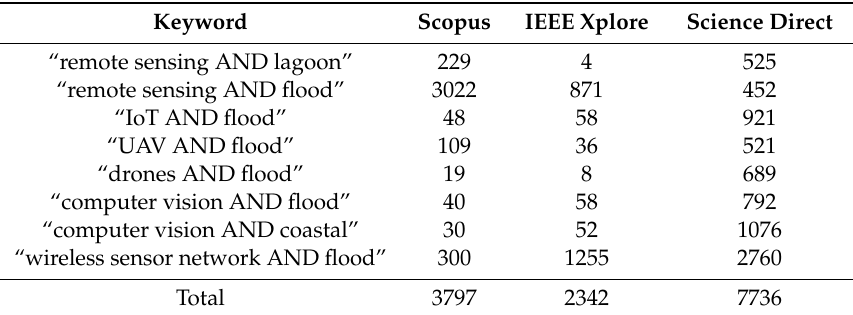
Table 1. Keyword search results from di ff erent online scholarly